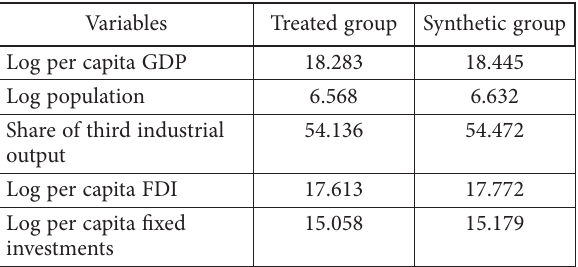
Table 7. Log land price predictor means